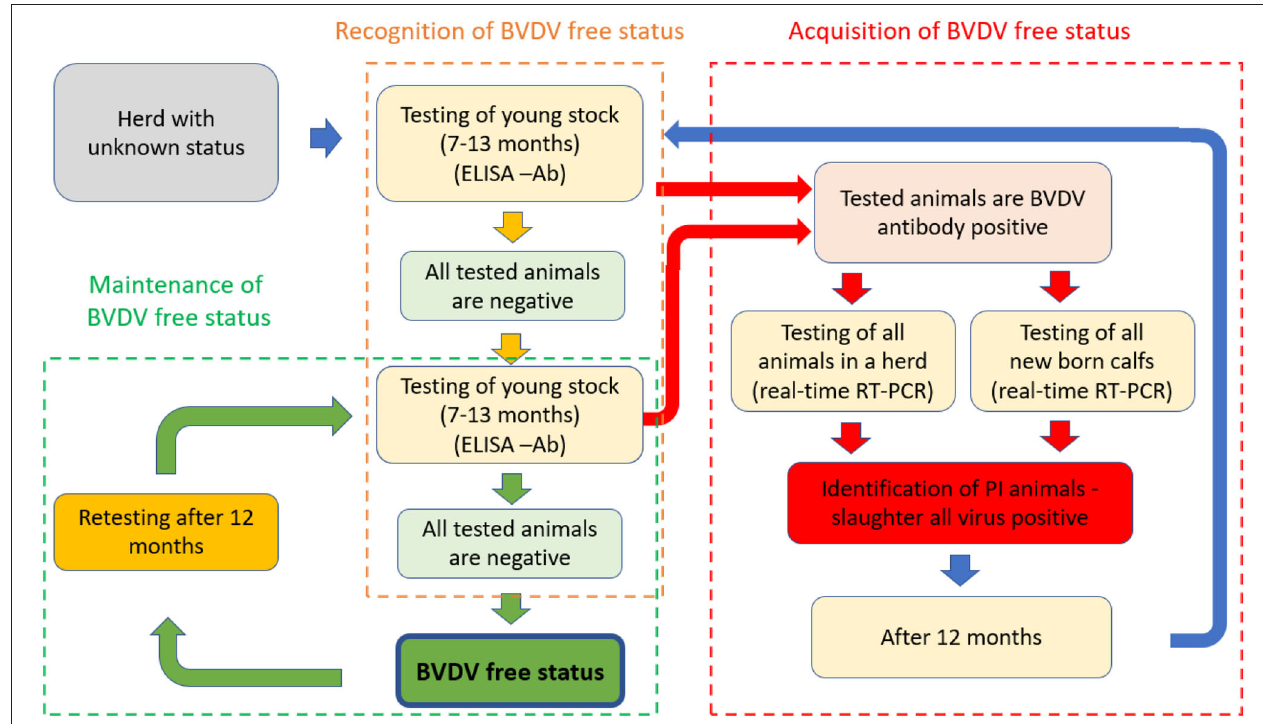
FIGURE 1 | The schematic presentation of basic principles of voluntary programme for the recognition, acquisition, and maintenance of BVDV-free status in Slovenia according to the Rule on the conditions for recognising, acquiring, and maintaining herd-free status of